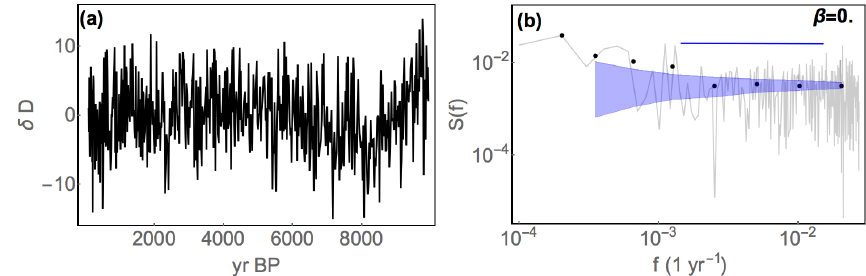
Figure 14. (a) δ D anomalies from the Holocene part of the EDC ice core. (b) Periodogram.